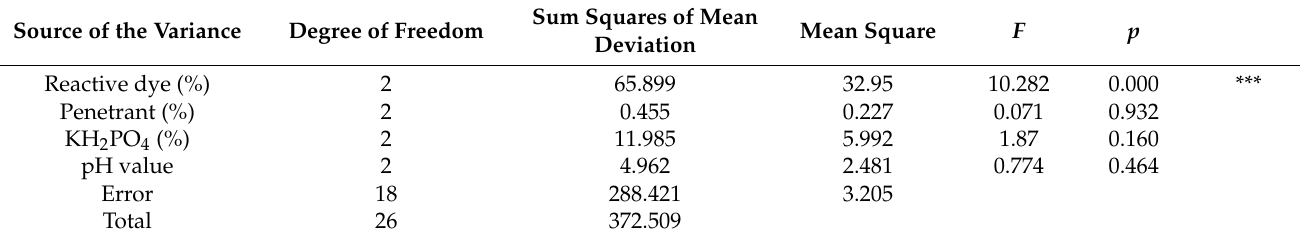
Table 6. Variance analysis of the color difference of dyed red-heart Chinese fir wood before and after soaking in water for 6 h. Source of the Variance